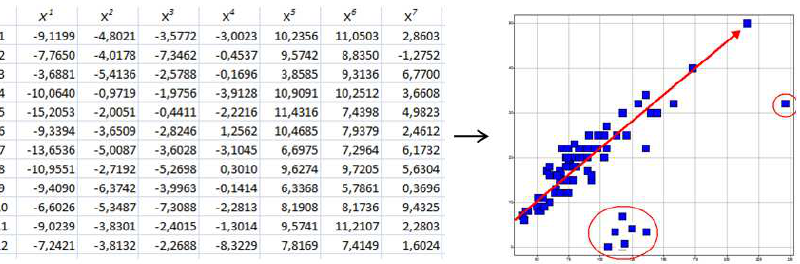
Figure 1. Visual presentation of the multidimensional